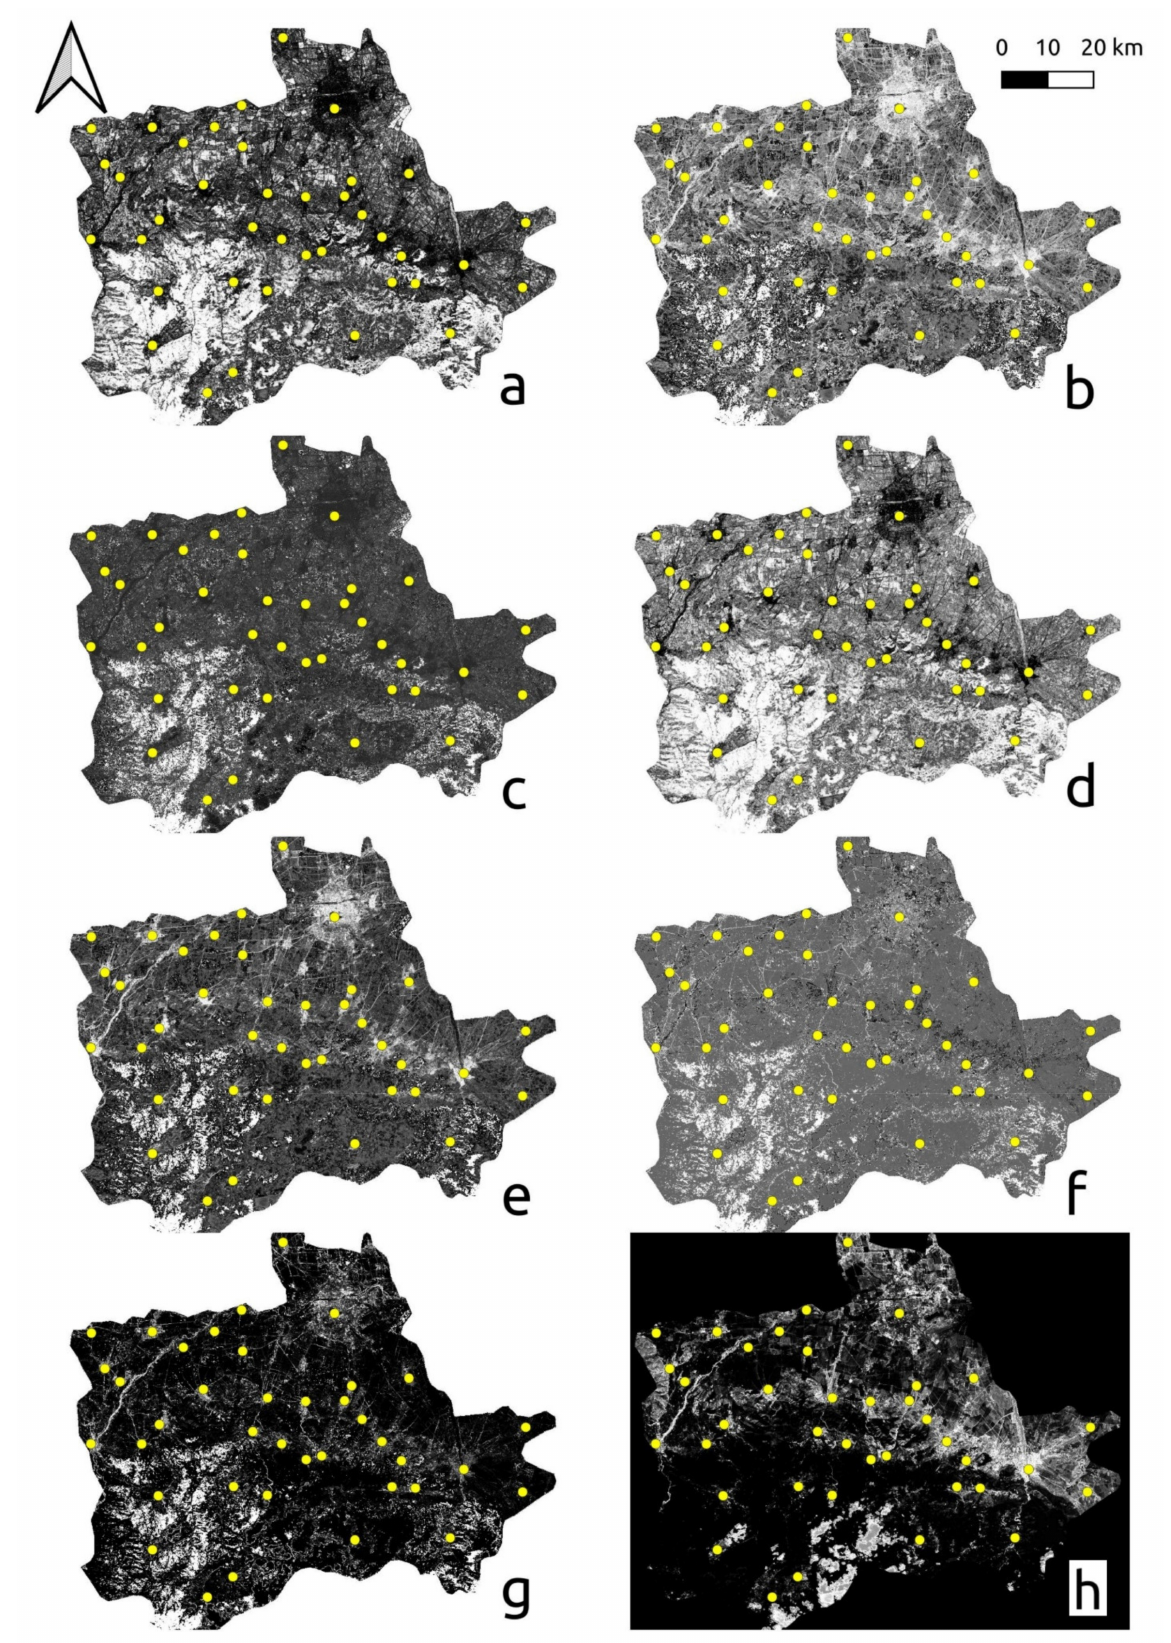
Figure 6. Haralick texture analysis of energy ( a ), entropy ( b ), correlation ( c ), Inverse Difference Moment (IDM) ( d ), inertia ( e ), cluster shade ( f ), cluster prominence ( g ), and Haralick correlation ( h